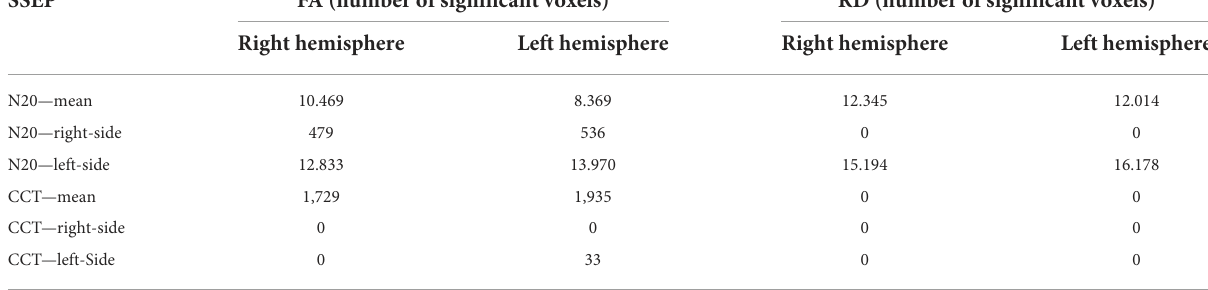
TABLE 6 To quantify asymmetry in right and left hemispheres the absolute amount of significant voxels ( p < 0.05) is shown, based on different latencies for the